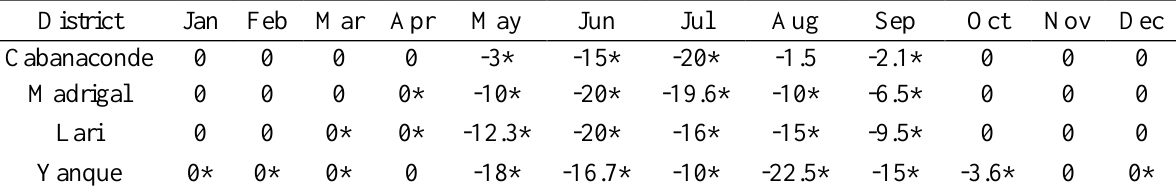
Table A 1 .5. Trends in the Number of Days under 0 °C per Month over the Period of 1988 to 2017 for the Different Districts District Jan Feb Mar Apr May Jun Aug Nov Dec Cabanaconde